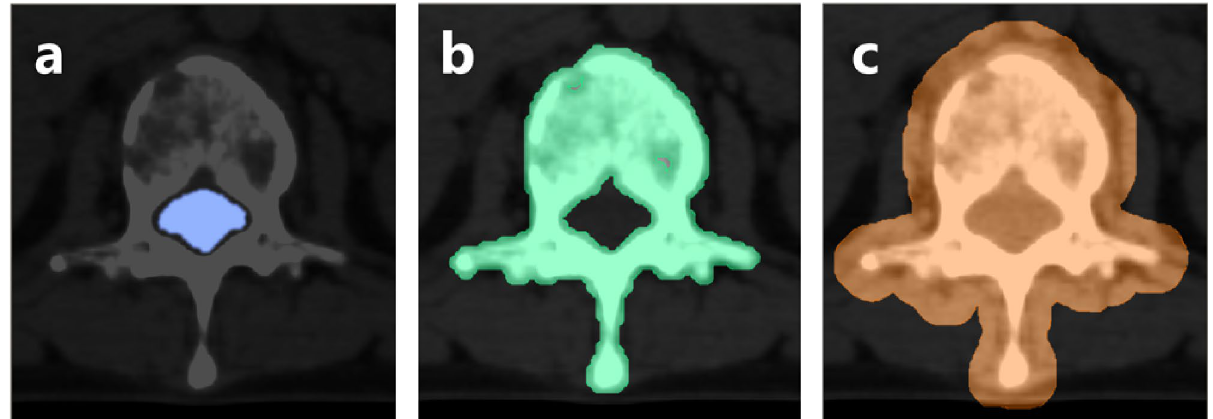
Figure 2. Segmentation of three regions of interest from CT images of patients with spinal metastases. ( a ) Spinal canal; ( b ) spine; ( c ) spine and surrounding